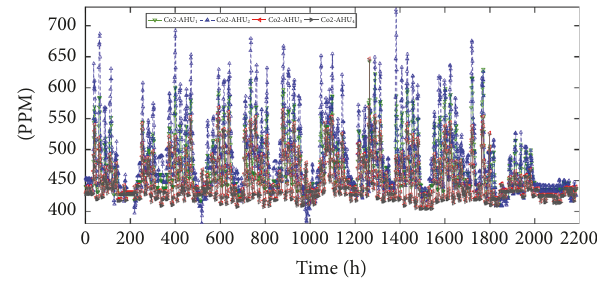
Figure 12: System outputs response zonal mean temperatures using lsim (sys, 𝑢 , 𝑡 , xo) function